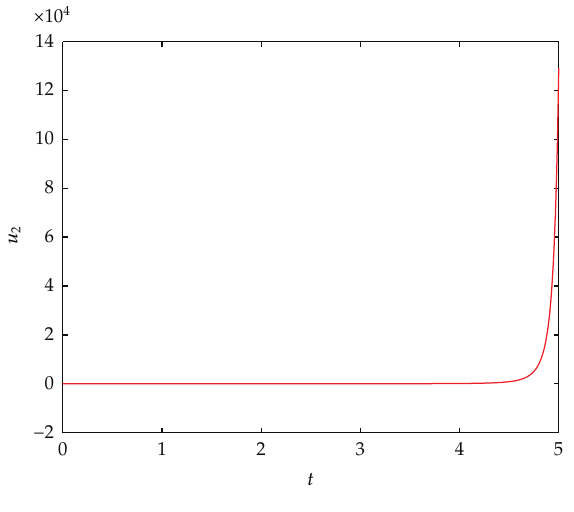
Figure 13: Component u 2